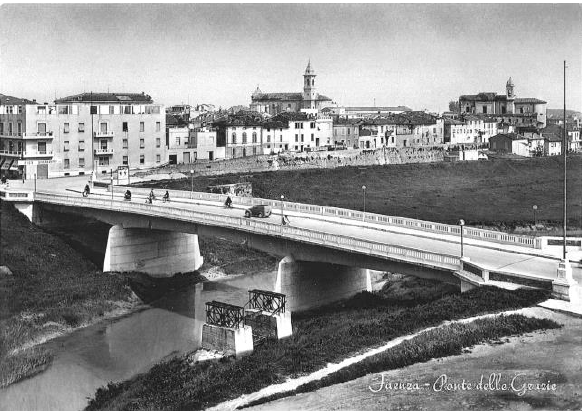
Figure 1. The “Ponte delle Grazie” bridge located on the Lamone River in an original postcard. The disadvantage of this structural typology is that the detail in the beam seat region represents a potentially sensitive structural detail. The side spans have a length of 21 meters, while the central span has a total length of 30 meters. The part of the bridge between the two piers is made by two 6 meters cantilever spans with a suspended span of 18 meters between them. The connection between cantilever and central span is made with Gerber half joints. The total length of the bridge is 72